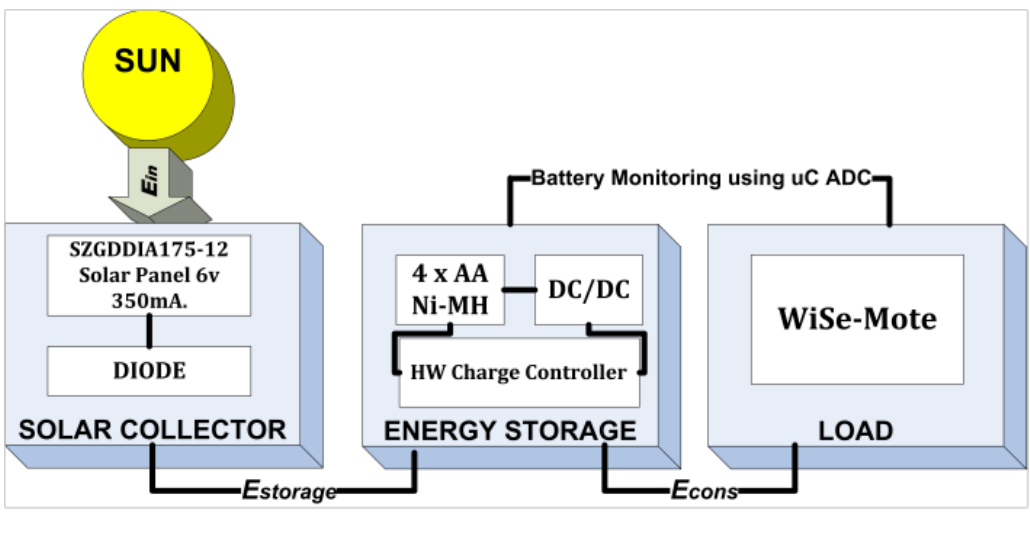
Figure 1. Model for a solar powered